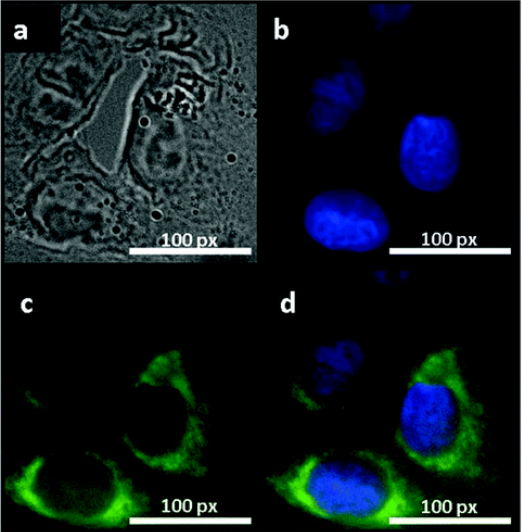
Figure 5. Fluorescent images of human breast cancer cells T47D after incubation with green GQDs for 4 h. ( a ) Phase contrast picture of T47D cells. ( b ) Individual nucleus stained blue with DAPI. ( c ) Agglomerated green GQDs surrounding each nucleus. ( d ) The overlay high-contrast image of the nucleolus stained with blue DAPI and GQD (green) staining. Reprinted with permission from [156]. Copyright 2012, American Chemical